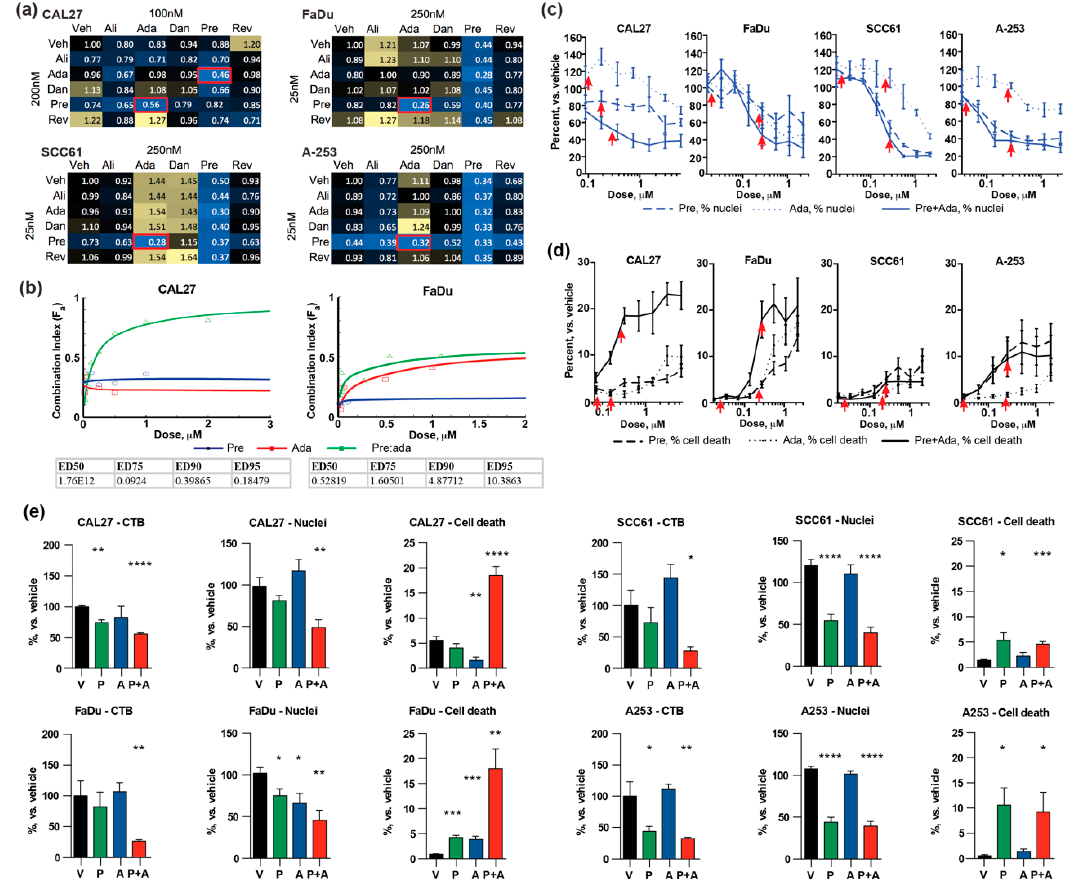
Figure 2. Evaluation of combination effect of selected cell cycle inhibitors. ( a ) Heatmaps representing values from CellTiterBlue (CTB) assays for combinations of the indicated targeted drugs, at the concentrations indicated. Values indicate reduction in cell metabolic activity normalized to vehicle control; blue, positive combination activity; yellow, antagonistic combination activity; red boxes, optimal combination; ( b ) combination index (CI) calculation results for the CAL27 and FaDu cell lines to assess synergistic effects of pre:ada drug combination; ( c,d ) dose response curves indicating viable cells (based on nuclear count) (c) and inviable cells (based on failure to exclude propidium iodide) (d). Arrows indicate concentrations comparable to those shown in CTB assays in ( a ); ( e ) Comparison of results from assays in ( a–d ) at drug concentrations used in ( a ). All graphs: *, p ≤ 0.05; **, p ≤ 0.01; ***, p ≤ 0.001; ****, p ≤ 0.0001 relative to vehicle controls.